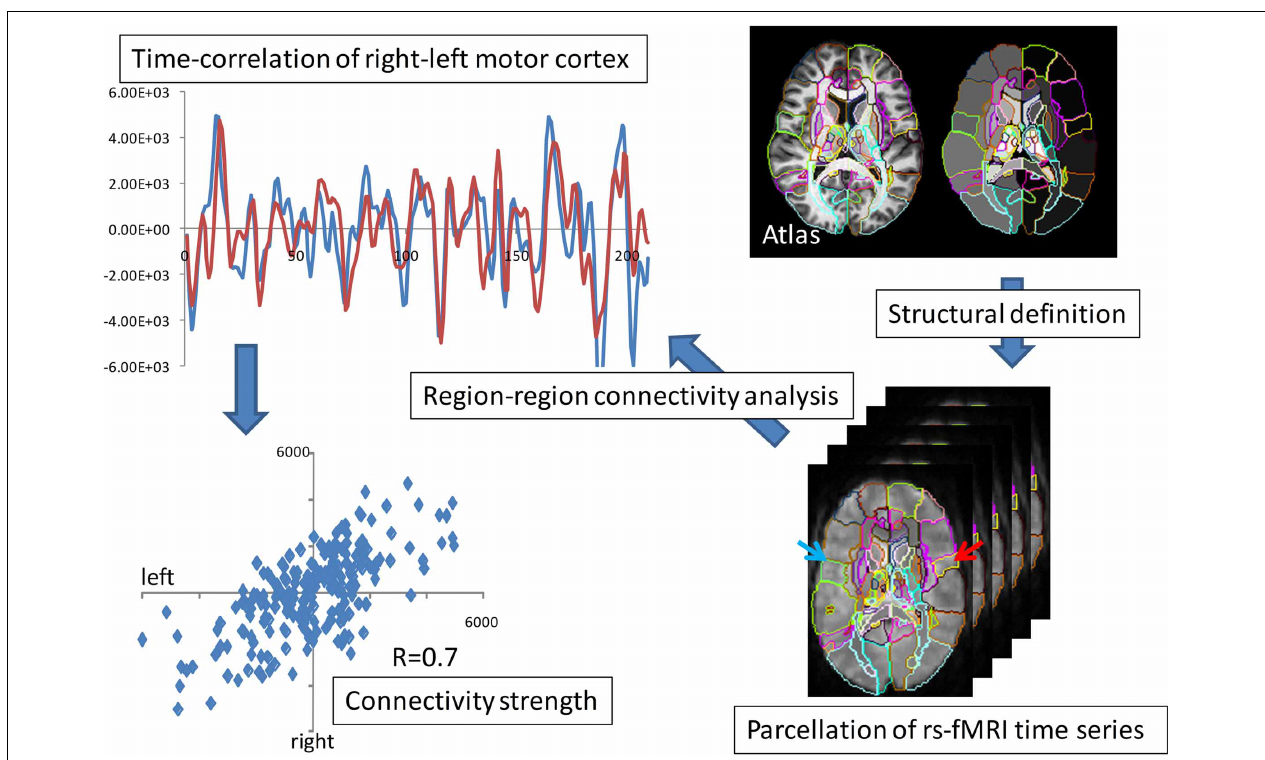
FIGURE 7 | fMRI parcellation based on resting state correlations. The top panel shows the overlap of the resting state functional signals integrated over the right-left motor parcellation; the bottom panel shows the value of blue and red time series over the 210 time